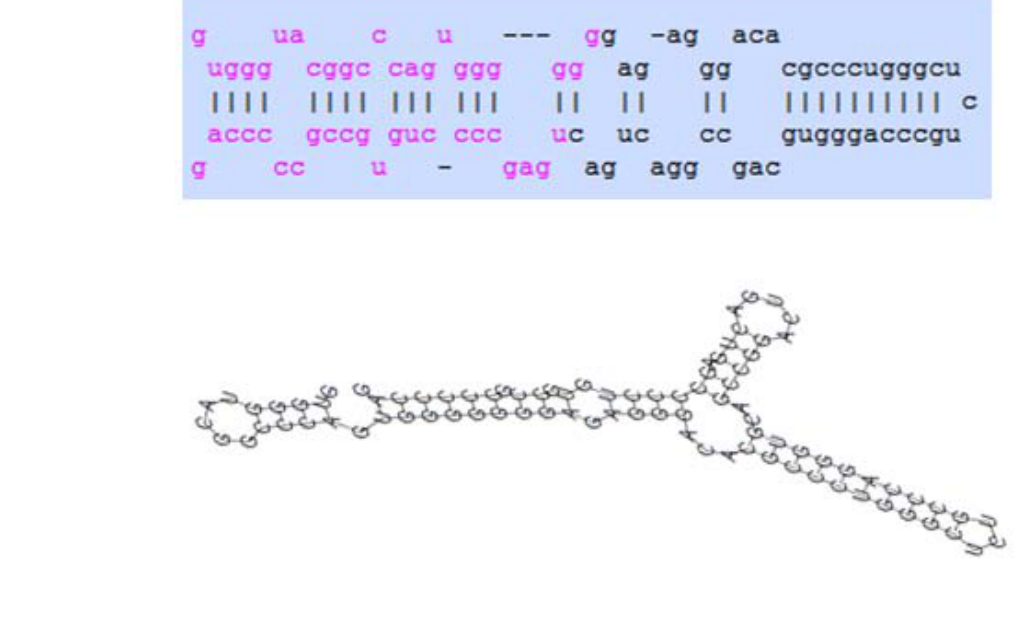
Figure 3: MiRBase entry for hsa-mir-1225 (MI0006311) showing the stem-loop structure as presented by miRBase (a). Pink bases indicate mature sequences. The hairpin structure has neither terminal loop nor flanking ends. Using RNAFold, a completely different structure is determined